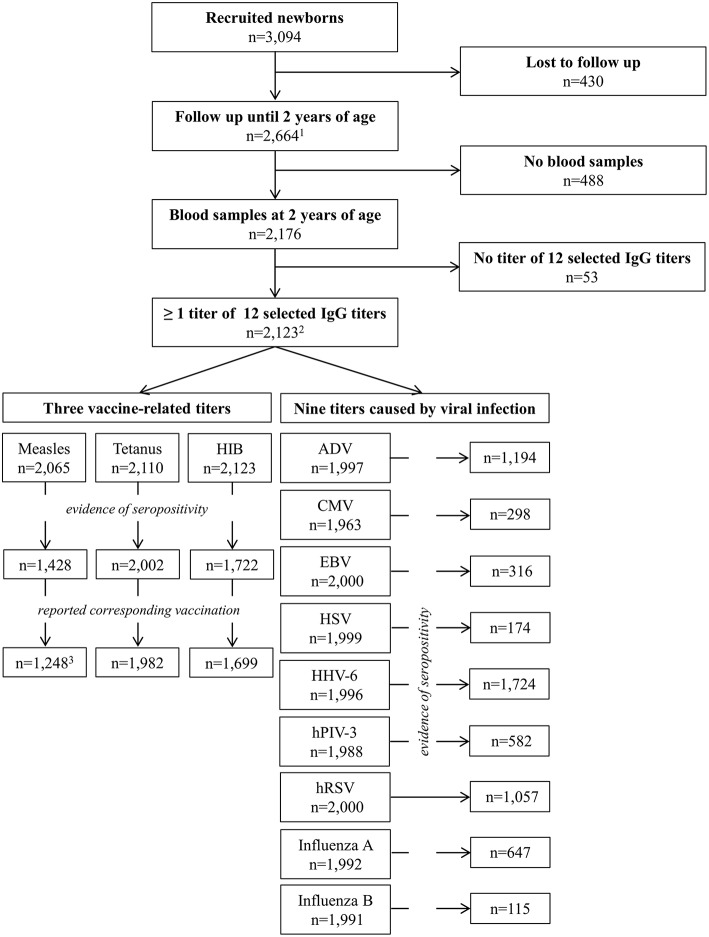
Flow Chart of included children by investigated IgG titers. (1) Of these 2,661 completed the 2-years-questionnaire. (2) Of some children the serum was insufficient for detection of certain IgG titers. (3) One child with corresponding measles infection excluded.